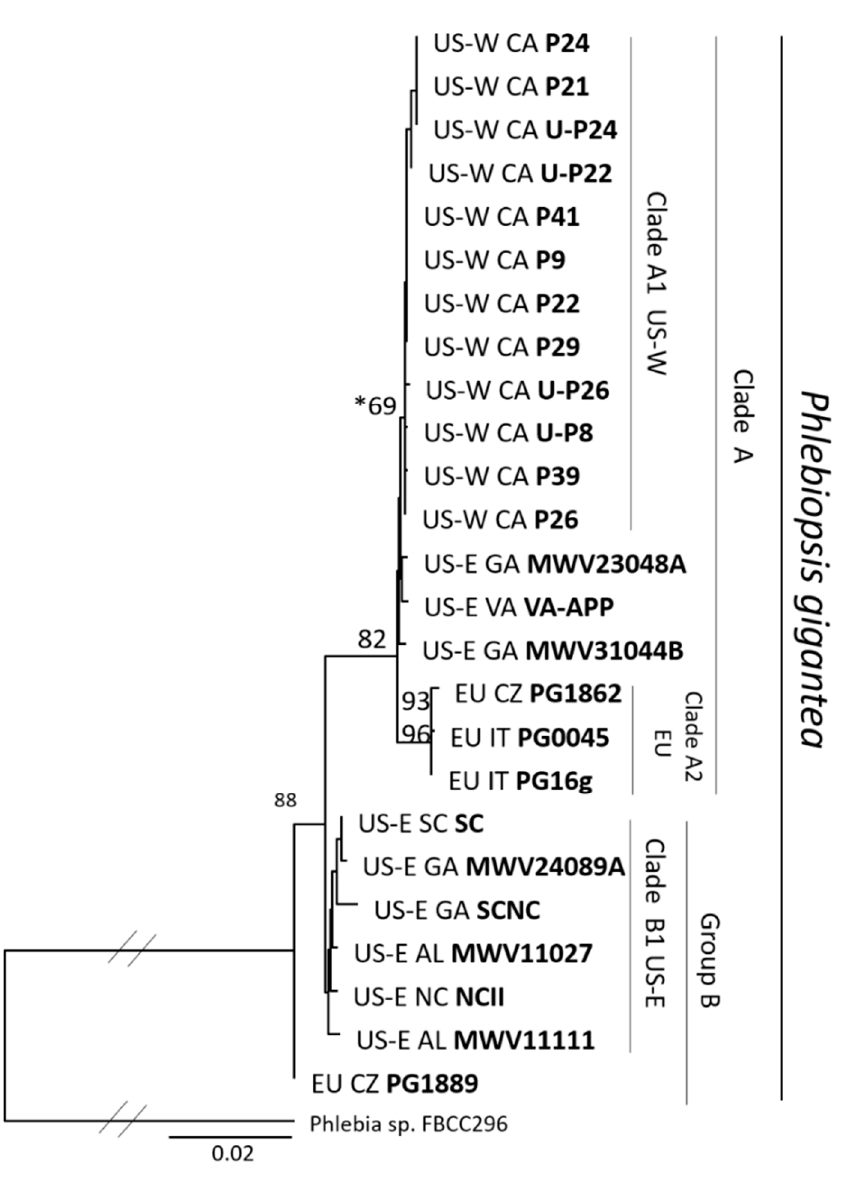
Figure 10. Maximum Likelihood phylogram obtained from the TEF1- α , nrITS, RPB1 , RPB2 and GPD combined sequence alignment . Phlebia sp . (FBCC296) was used as outgroup taxon. Only MLB values ≥ 69% are given above clade branches.